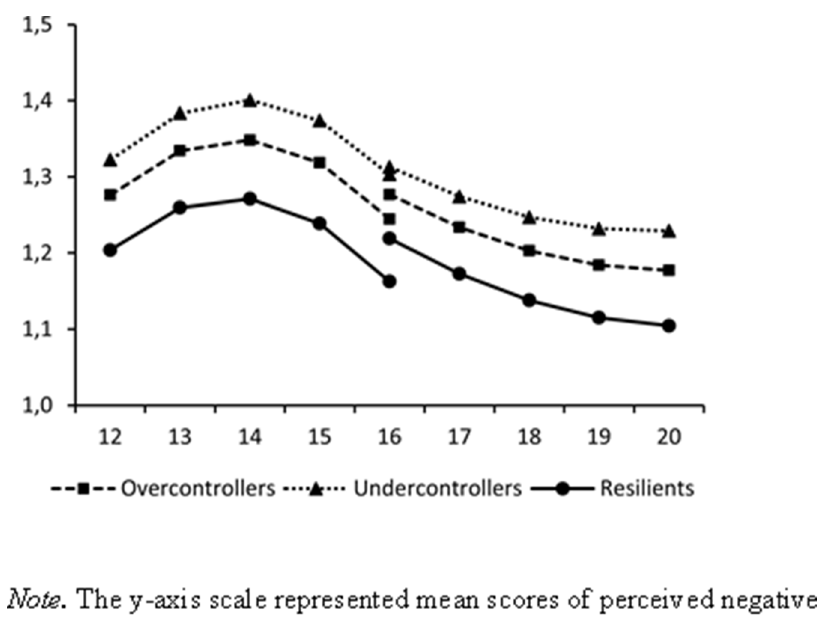
Figure 3. Estimated Developmental Changes in Adolescent Friendship Negative Interaction by Adolescent Personality Types.